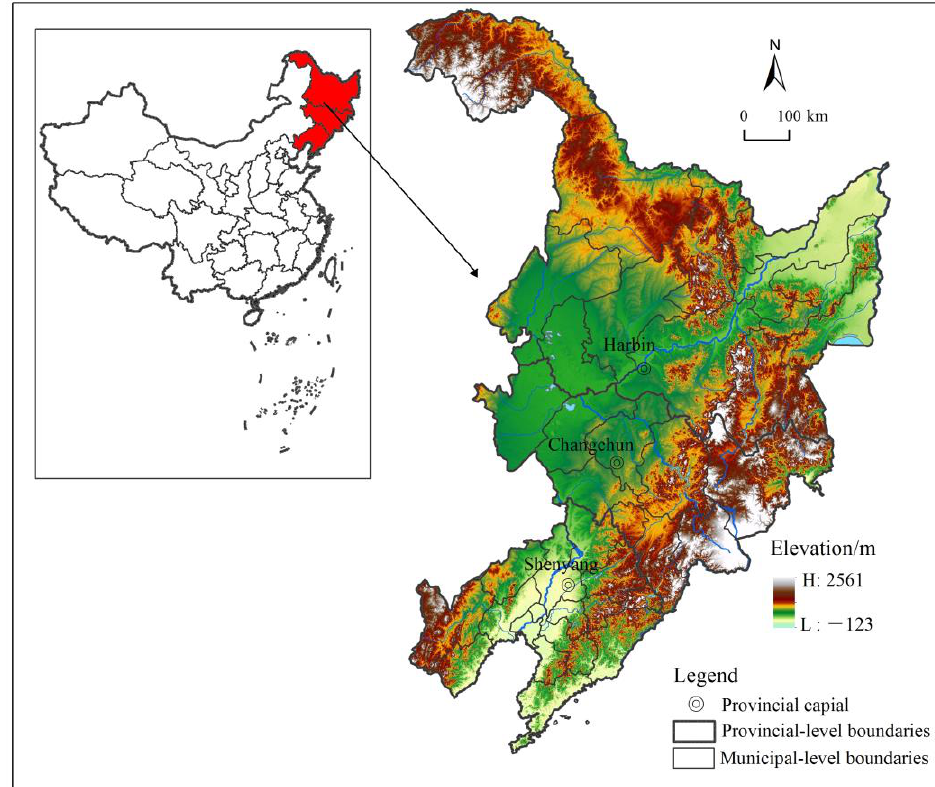
Figure 2. Overview of the Research Region.